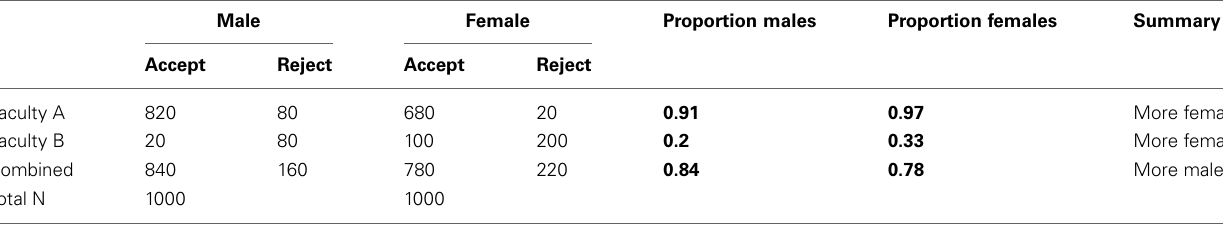
Table 1 | A stylized representation of Berkeley admission